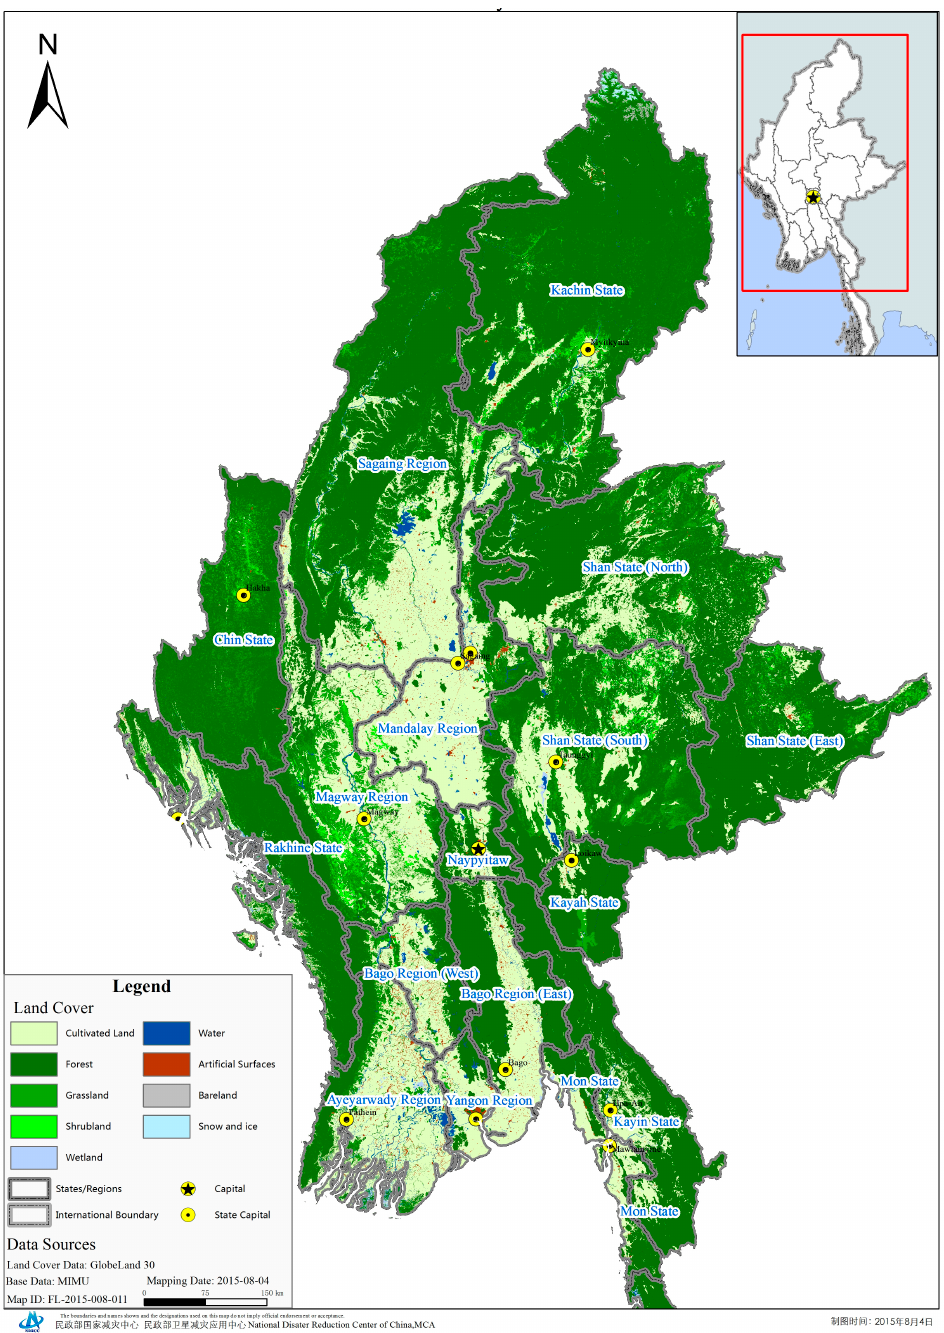
Figure 2. Landcover Map of Myanmar of 2010.